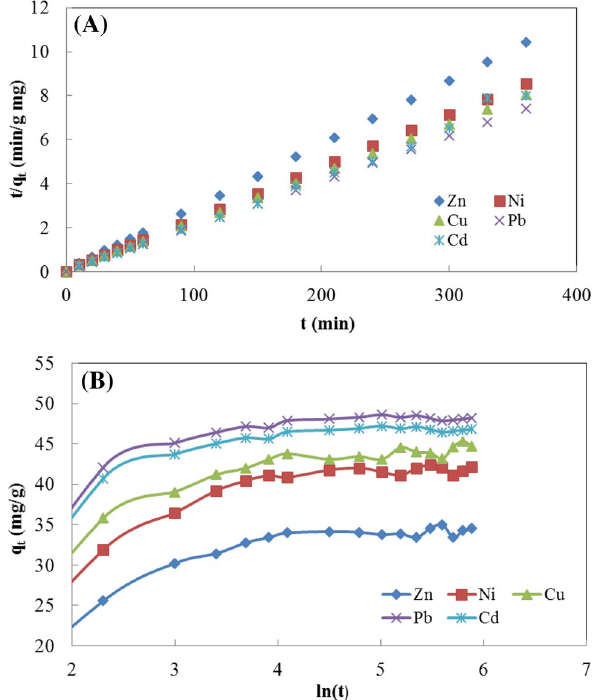
Fig. 5 a Effect of contact time on the % metal removal and b on the uptake of Zn (II), Ni (II), Cu (II), Pb(II) and Cd (II) by Posidonia oceanica